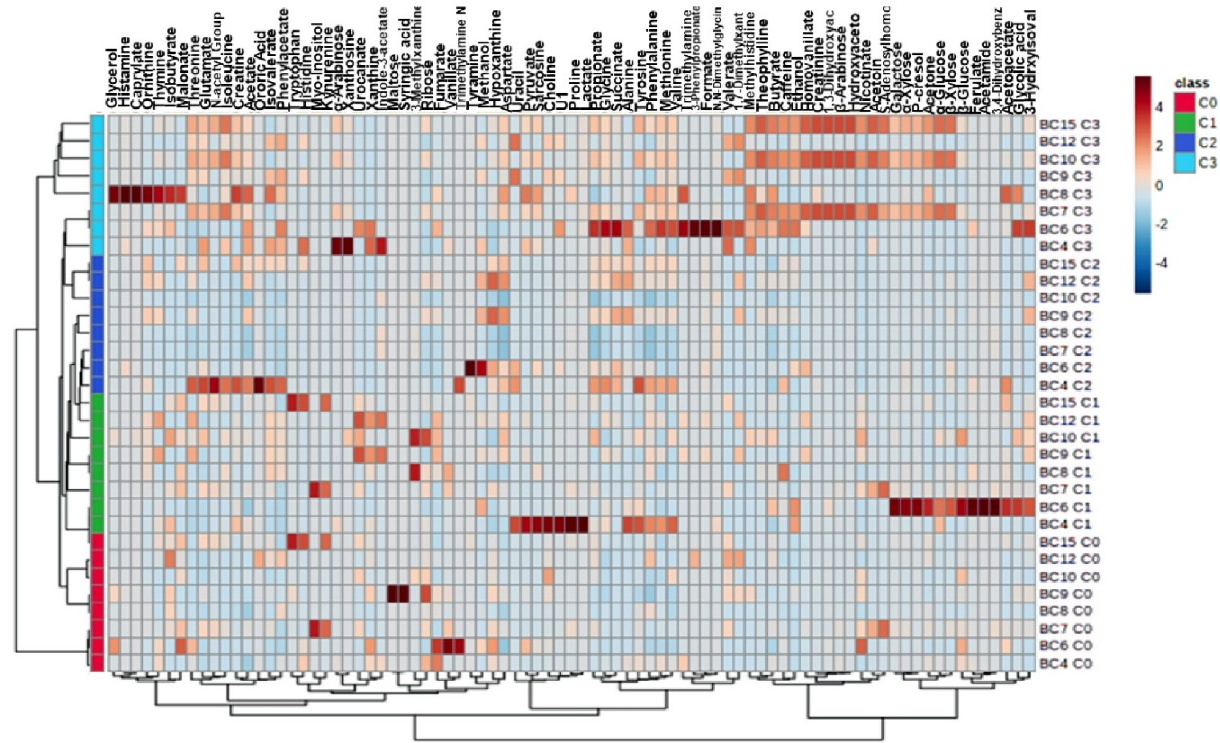
Figure 3. Heat map of differential metabolites among the groups. The color of each section represents the significance of the change of metabolites (red: upregulated; blue: downregulated). Rows: metabolites; columns: samples.